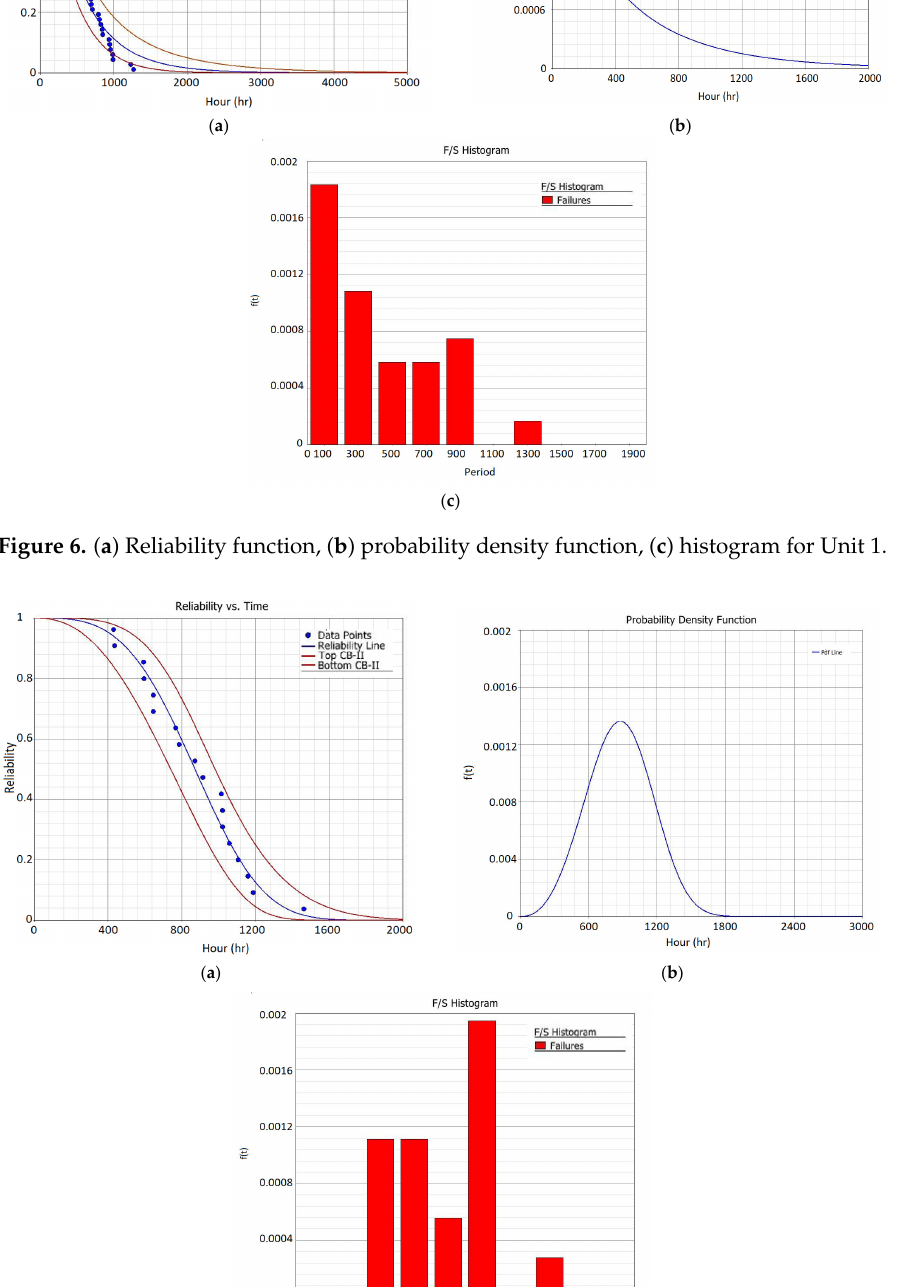
Figure 7. ( a ) Reliability function, ( b ) probability density function, ( c ) histogram for Unit 2.